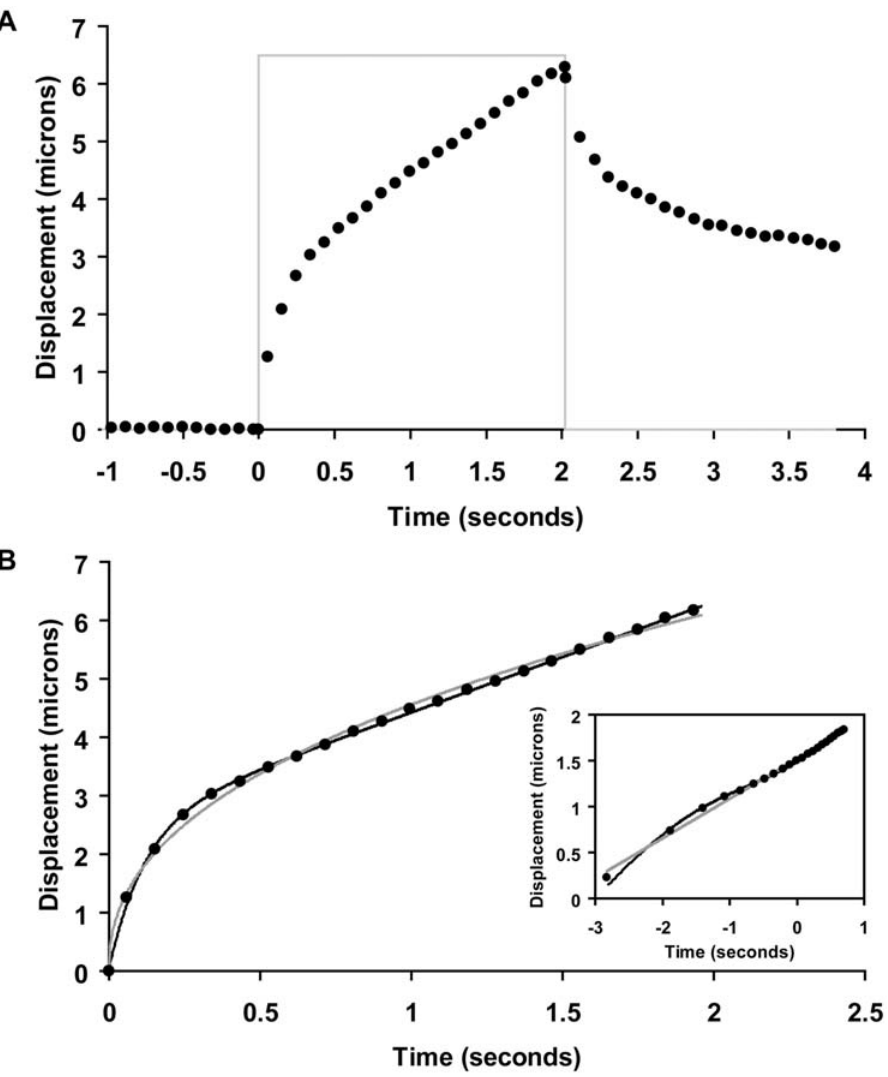
Figure 3. The cytoplasmic trajectory of a magnetic bead. A.Typical bead trajectory under a 2-second constant force pulse (filled circles: bead position; gray line: magnetic pulse; ‘‘0’’ on the time axis represents the moment when the force pulse was applied). B. Best fit to the trajectory during creep ( F ? 0). Filled circles: experimental data points; black line: best fit with the linear viscoelastic model; gray line: best fit with the power law. Inset: bead trajectory on a log-log scale. The numbers along both axes are powers of e, the base of natural logarithm.